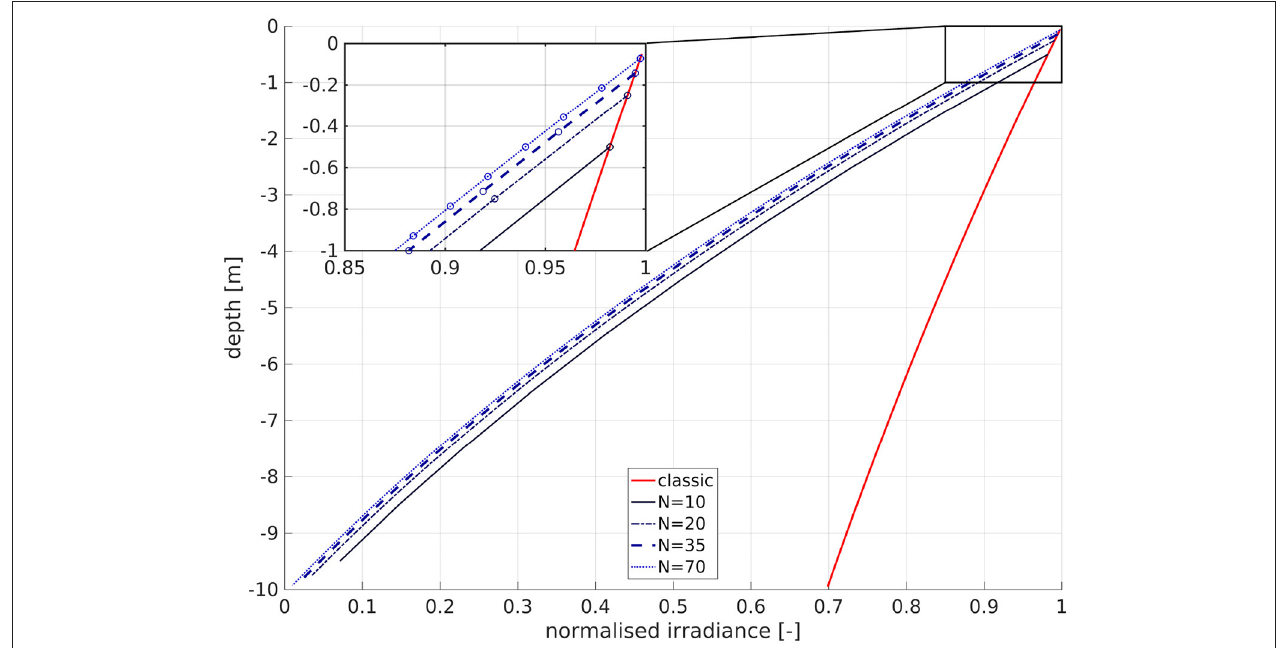
FIGURE 1 | Influence of number of layers N on the attenuation of normalized irradiance for a depth of 10 m. The abscissa is normalized irradiance, and the ordinate is depth. The solid red line is the classic scheme, the other lines are for the IND scheme: solid black is for N = 10, dark blue dashed is for N = 20, bold dashed blue is for N = 35 (as in our model), and dotted blue is for N = 70. The circles in the magnified inset denote the cell center depths of the respective layers.